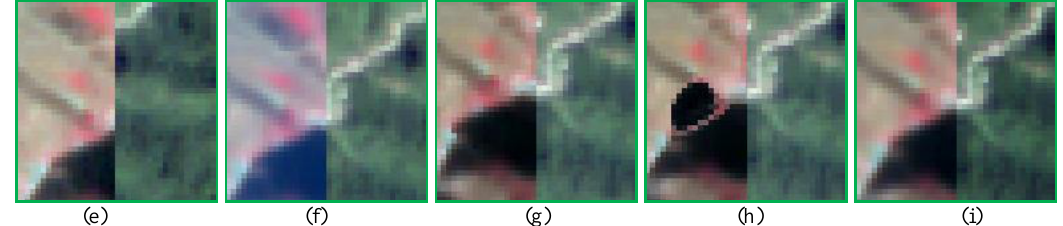
Figure 4. The first experiment. (a) Reference image. (b) Sensed image. (c) Overlapping of the original images. (d) Overlapping of the reference and aligned image from the proposed method. Magnified images of selected area marked in red and green rectangles from (e) the original images, (f) PLM (Goshtasby 1986), (g) BWP (Feng et al. 2017), (h) optical flow without post-processing (Brox et al. 2004), and (i) The proposed method (DM_OF).